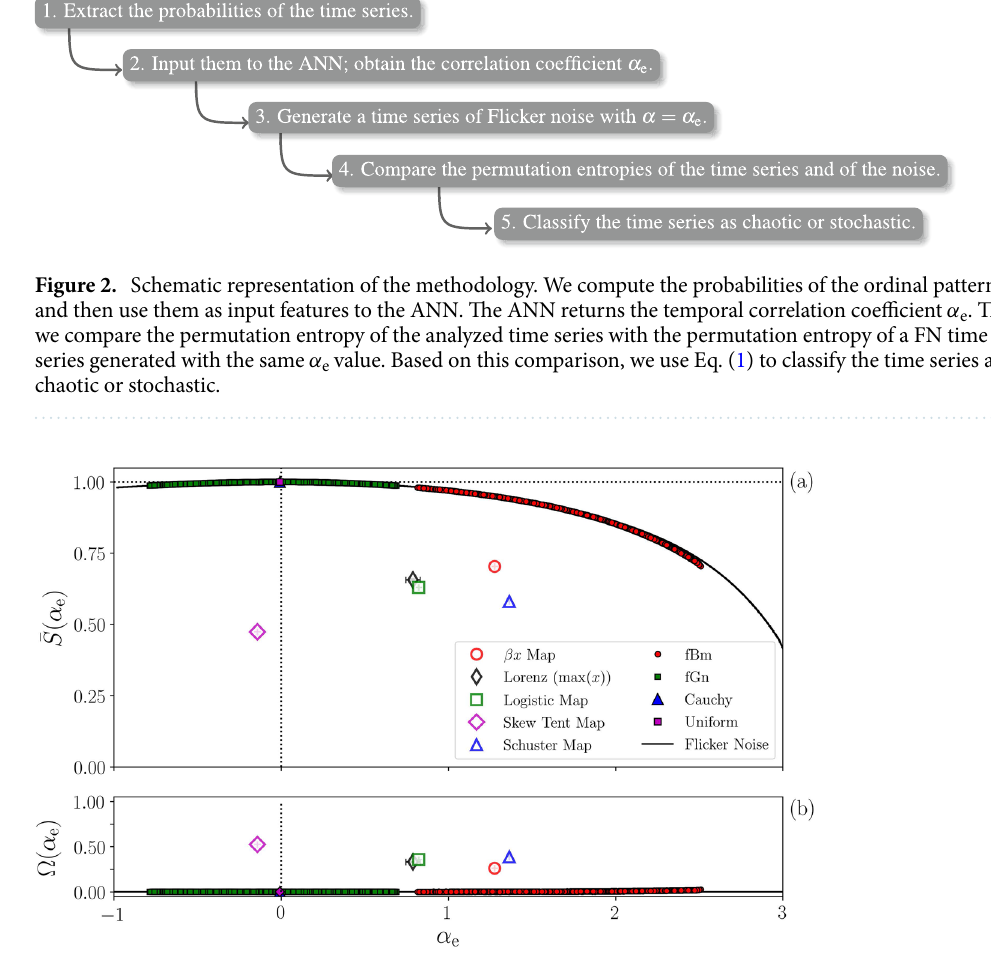
Figure 3. Temporal correlation and distinction of chaotic and stochastic synthetic signals. Panel ( a ) shows the normalized permutation entropy ¯ S as a function of α e , evaluated through the ANN, for different time-series (stochastic and chaotic). The black solid line represents FN signals, which are used for training and testing the ANN. Filled symbols represent different stochastic signals, which are very close to the FN curve. Empty symbols represent chaotic signals, which are far away. The distance to the FN curve is measured by (cid:31) (Eq. 1) and it is shown in panel ( b ) higher values of (cid:31) indicate chaotic time series, while lower, vanishing values indicate stochastic